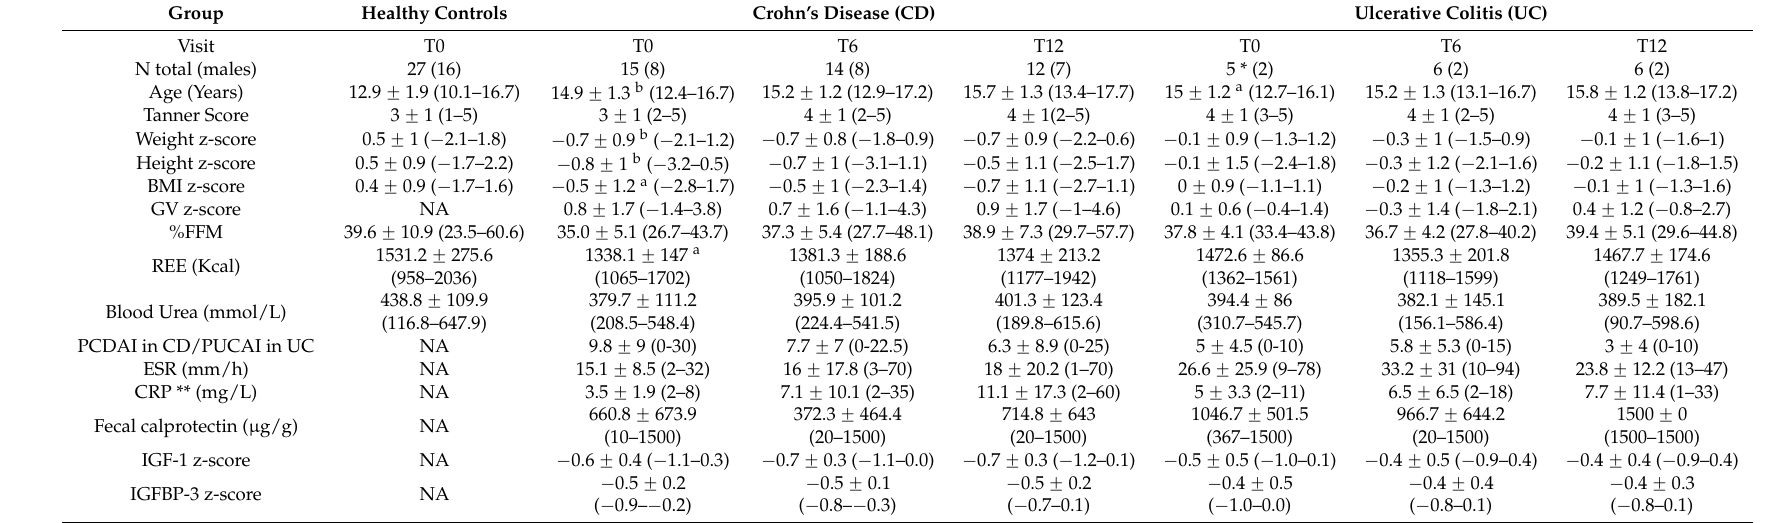
Table 1. Population